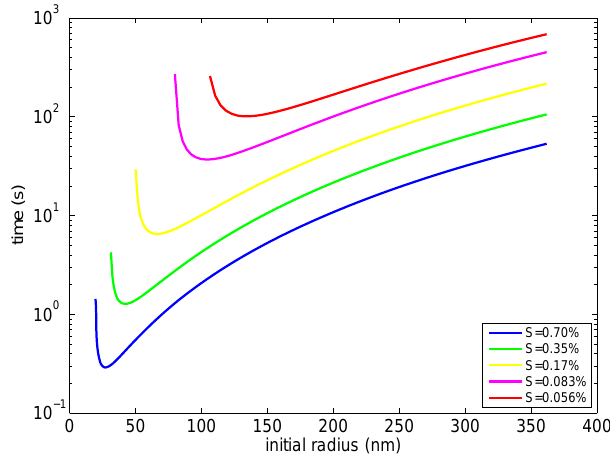
Fig. 7. The time required for particles to grow to their critical radii at different supersaturations. The x-coordinate is the initial dry radii of aerosols, the composition of aerosols is ammonium sulfate and different colours represent different supersaturations. Water accom- modation coefficient is